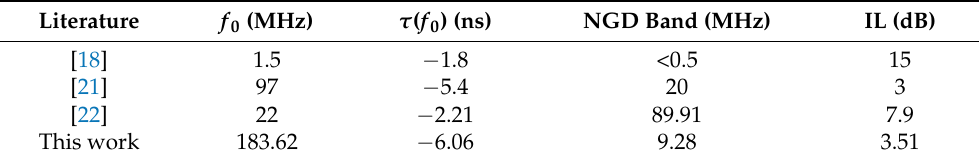
Performance comparison between band-pass negative group delay and reported NGD